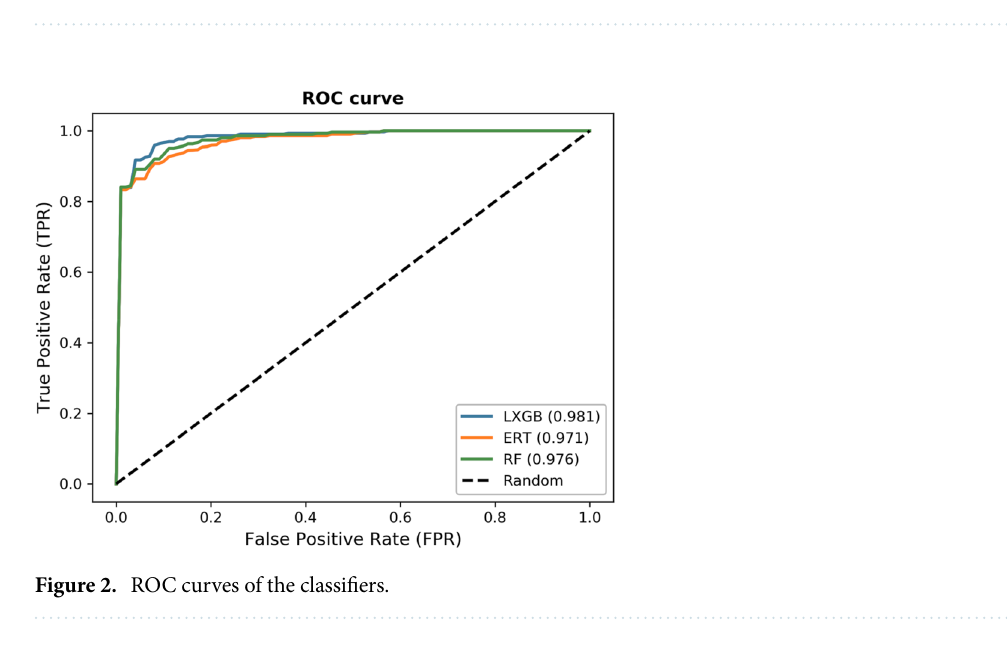
Table 4. Results based on the best feature set.